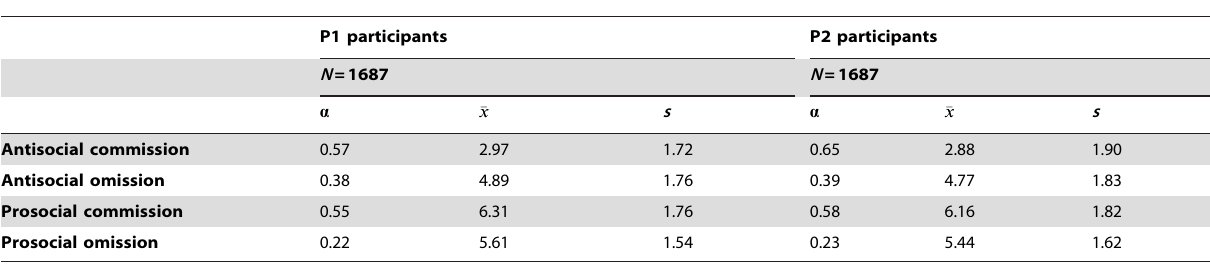
Table 1. Descriptive Statistics for Lying Subscales.